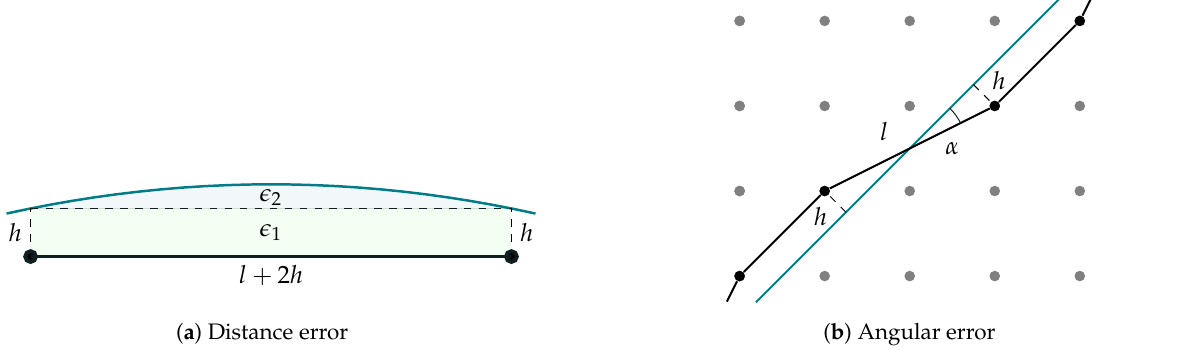
Figure 1. Geometrical error bounds. Blue line: continuous optimal solution. Black line: discrete optimal solution. Gray dots: graph